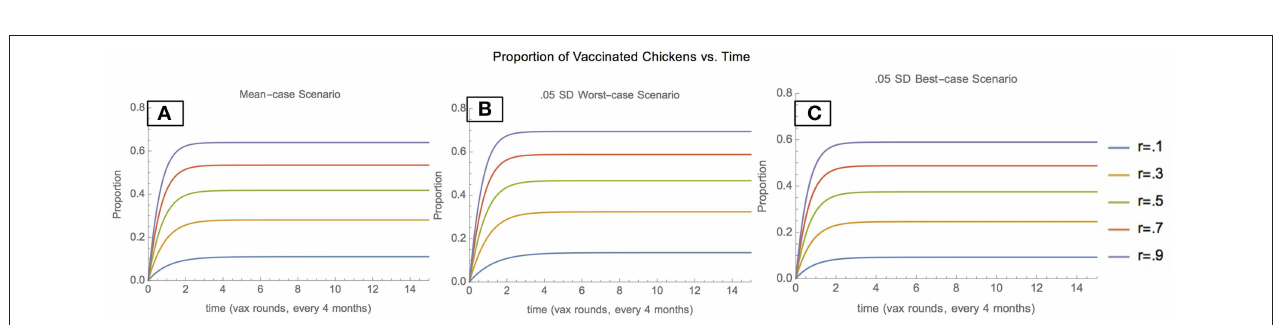
Frontiers in Veterinary Science |